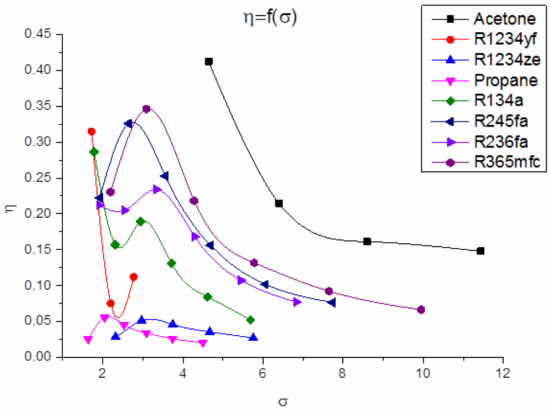
Figure 5. Efficiency against pressure ratio for different working fluids.